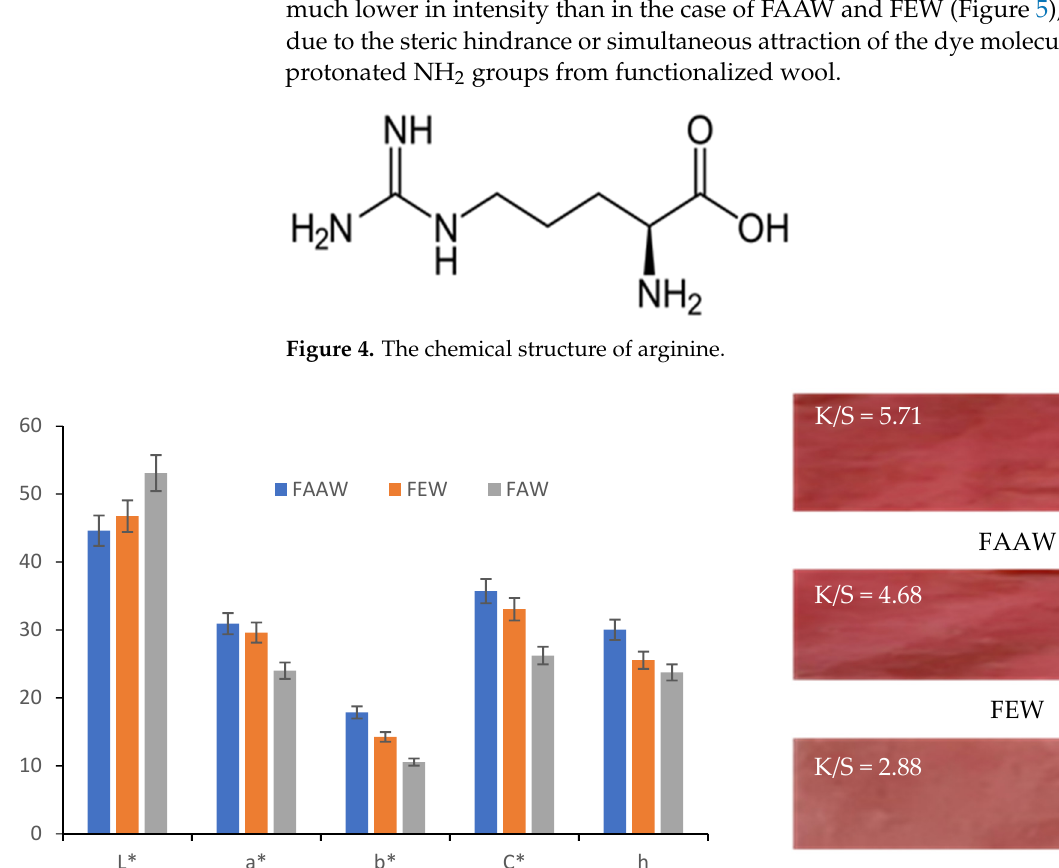
Figure 6. FTIR spectra for: untreated wool (1); protonated and dyed wool (2).